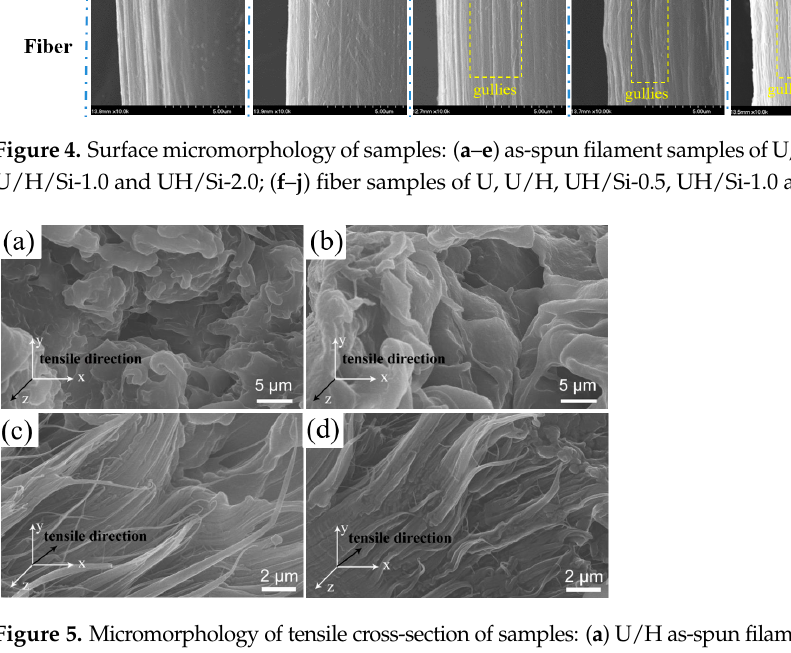
Figure 5. Micromorphology of tensile cross-section of samples: ( a ) U/H as-spun filament; ( b ) U/H/Si-0.5 as-spun filament; ( c ) U/H fiber; ( d ) U/H/Si-0.5 fiber.